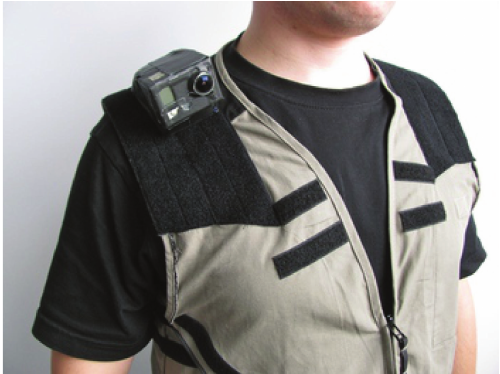
Figure1:WearablecamerarecordingprototypeusedintheIMMED